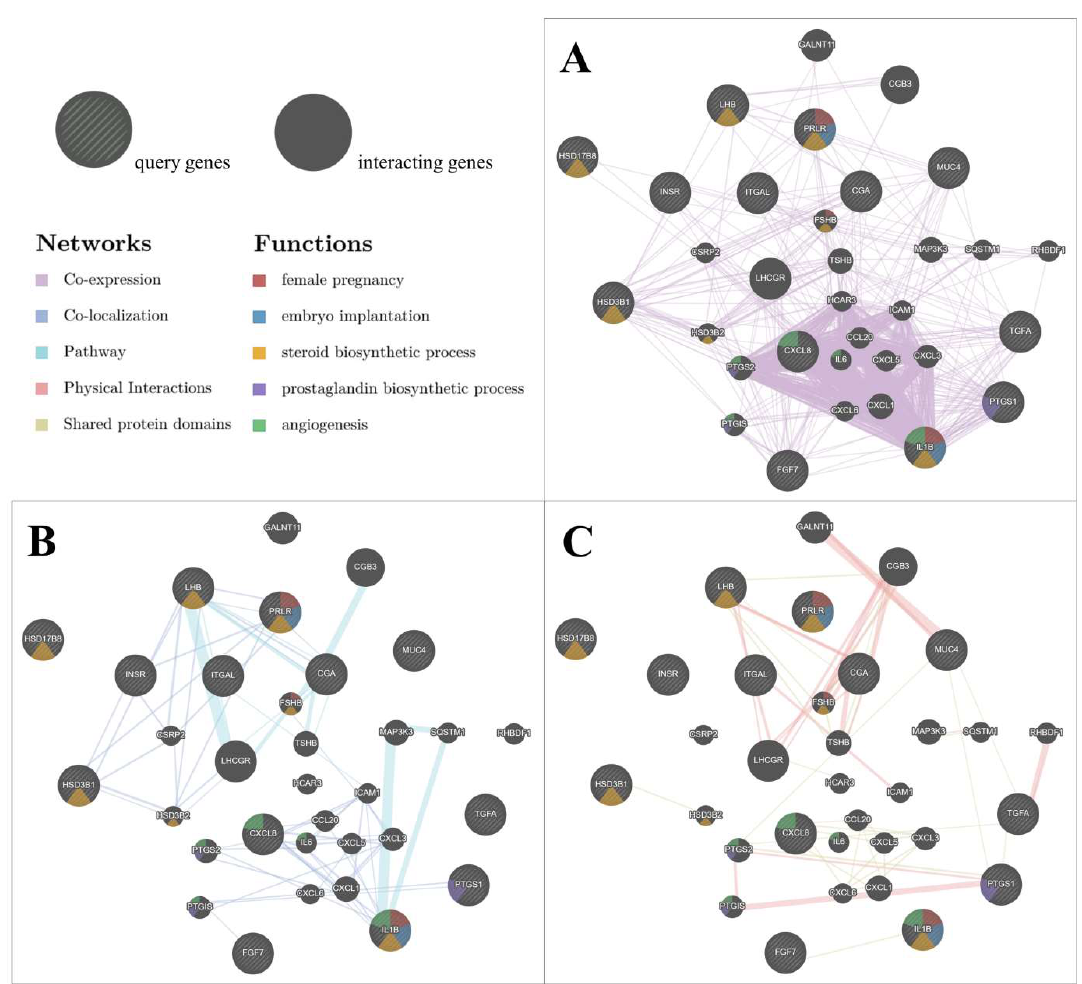
Figure 1. Gene interaction networks created in GeneMania for selected genes. The relations between the chosen genes based on their known participation in female reproduction and metabolism (query genes, striped circles) and additionally automatically generated genes mediating in the biological processes (interacting genes, non-striped circles). Colours on the circles indicate the contribution of the genes in the specific biological functions. The size of the circle indicates the importance of the gene in the specific interactions. The colour of the lines connecting the genes denotes the type of interaction: co-expression ( A ), co-localization and pathways ( B ), as well as physical interactions and shared protein domains ( C ), while the width of lines indicates the weight of interaction between genes (refer to the